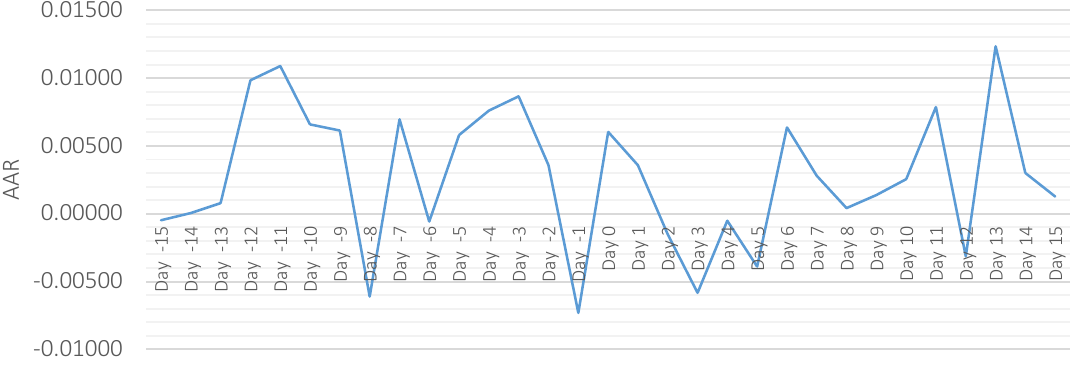
Figure 7. Average Abnormal Returns (AAR) of the Service